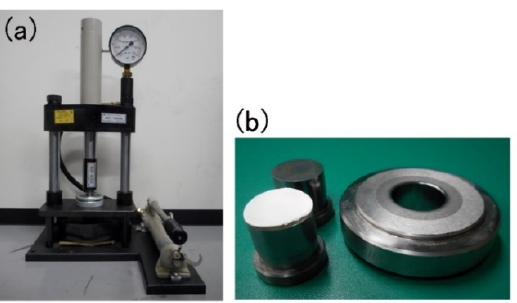
Figure 1. ( a ) A hydraulic press machine used in this study, ( b ) s pecimen on the